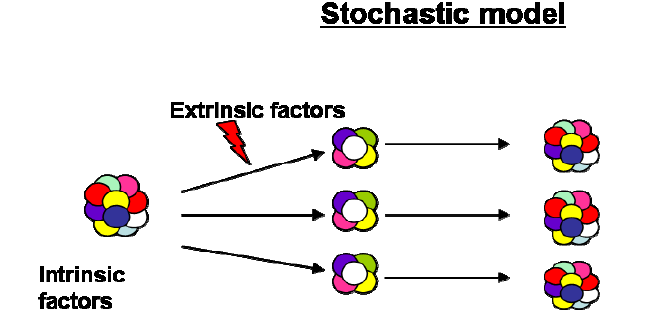
Figure 1. Models of tumor heterogeneity. Tumor heterogeneity has been explained by two theories: according to the stochastic model, tumor cells are influenced by intrinsic and extrinsic factors; by contrast, in the hierarchy model, tumor cells have different functional abilities and only a subset can initiate tumor